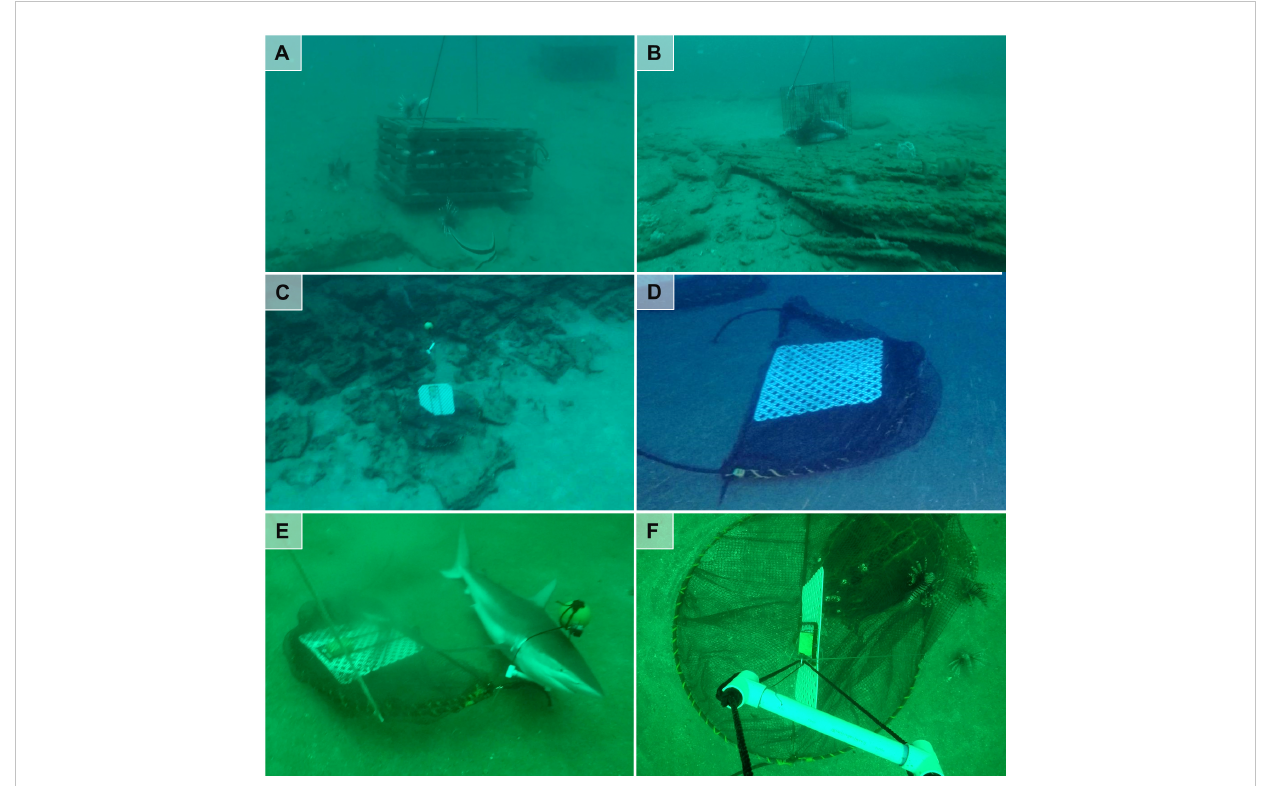
FIGURE 4 Operational performance issues observed while testing experimental lion fi sh traps near northeastern Gulf of Mexico mesophotic reefs. Photos show unintended placement on natural reef structure by (A) lobster, (B) sea bass, and (C) Gittings traps, as well as (D) a Gittings trap that failed to open upon contact with the bottom, (E) an unexpected megafauna entanglement of a dusky shark ( Carcharhinus obscurus ) in the buoy line, and (F) a green sea turtle ( Chelonia mydas ) that crawled under a Gittings trap and became entangled in the trap ’ s netting. Photos by the